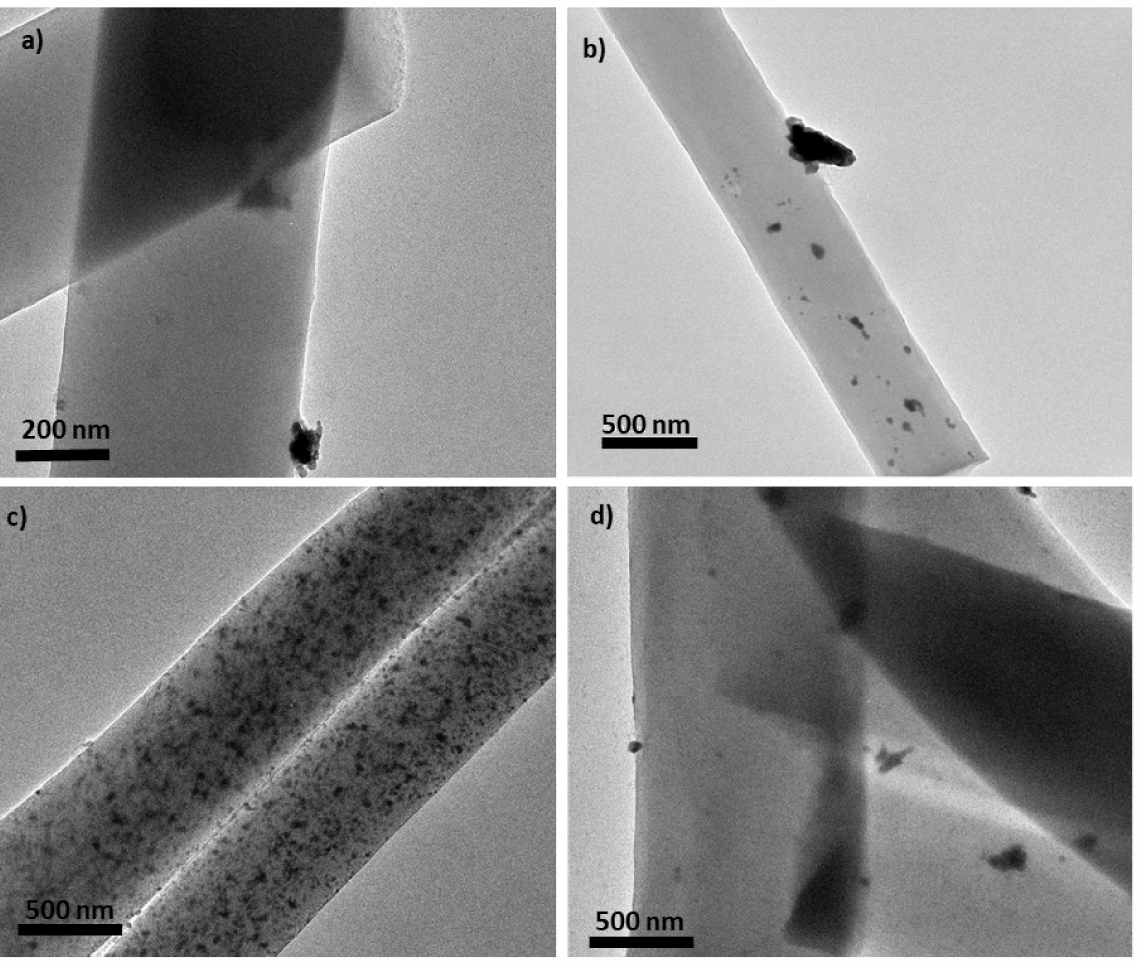
Figure 4. TEM images of the following samples: ( a ) 1% Pd/CF1, ( b ) CF3, ( c ) CF4, and ( d ) CF5. Another observed difference in H 2 consumption was noticed for different electrospin- ning flow rates used in catalysts synthesis, i.e., fixing the same method of Pd incorporation on CFs, but with an electrospinning flow rate of 2 mL min − 1 allowed to obtain higher H 2 consumption than the others with 0.5 mL min − 1 (1% Pd/CF2 > 1% Pd/CF1). This also could be related to the textural properties of these catalysts, which were observed to present a higher surface area in 1% Pd/CF2 than 1% Pd/CF1, resulting in higher availability of Pd particles for H 2 chemisorption. Table 3 shows that all catalysts demonstrated loadings of ~1% of Pd independently of the impregnation method used. The small deviations from the nominal value are consistent with those expected for the techniques used, including the analytical technique requiring sample